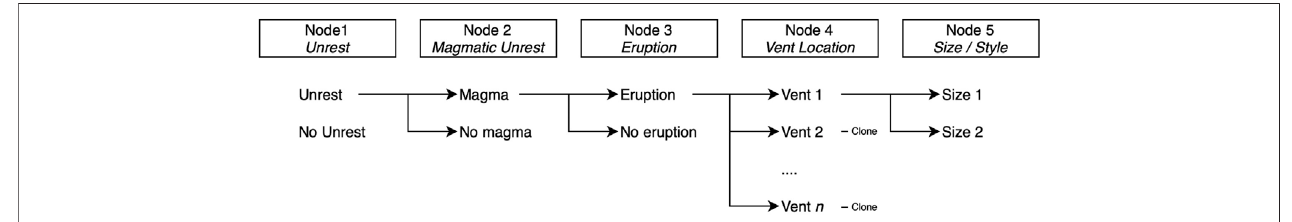
FIGURE2| SchematicdiagramofBET_EFframework.Theprobabilityoftheselectedpathistheproductofconditionalprobability θ i atallselectedbranches:[ θ ] path (cid:129) (cid:129) (cid:129) (cid:129) = [ θ 1 ] [ θ 2 ] [ θ 3 ] [ θ 4 ] [ θ 5 ]. Any branch that terminates with “ clone ” is identical to that of the top branch for that